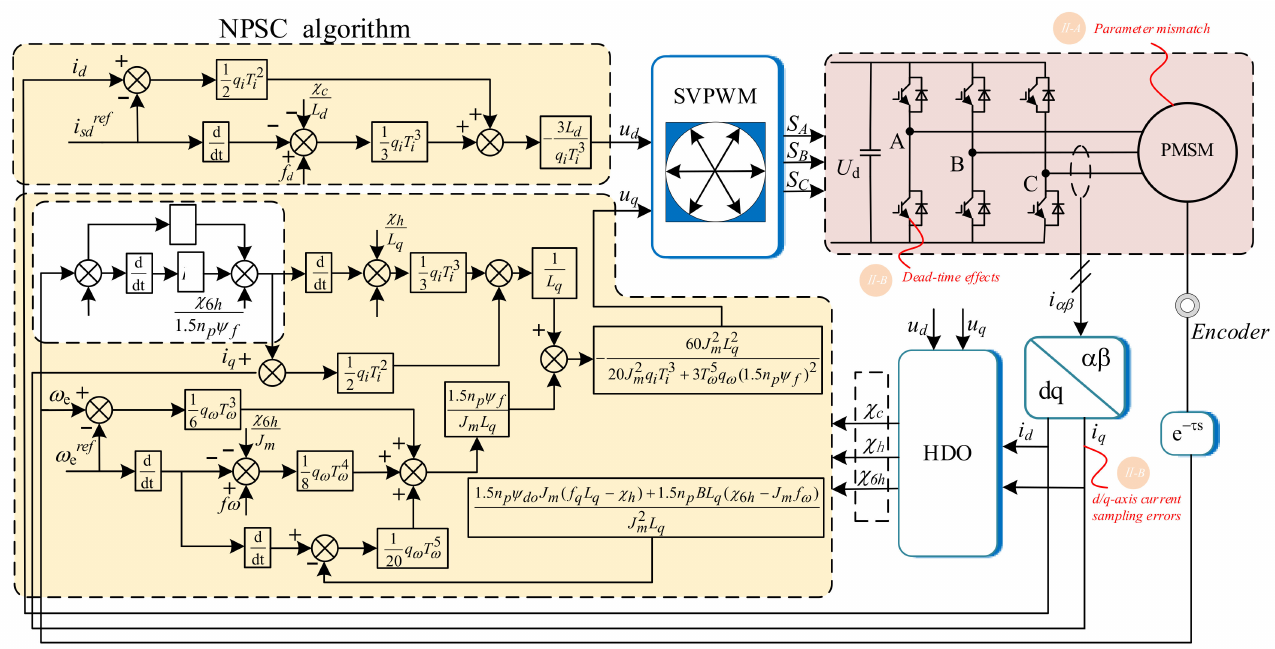
Figure 1. Control block diagram of the proposed HDO-NPSC.